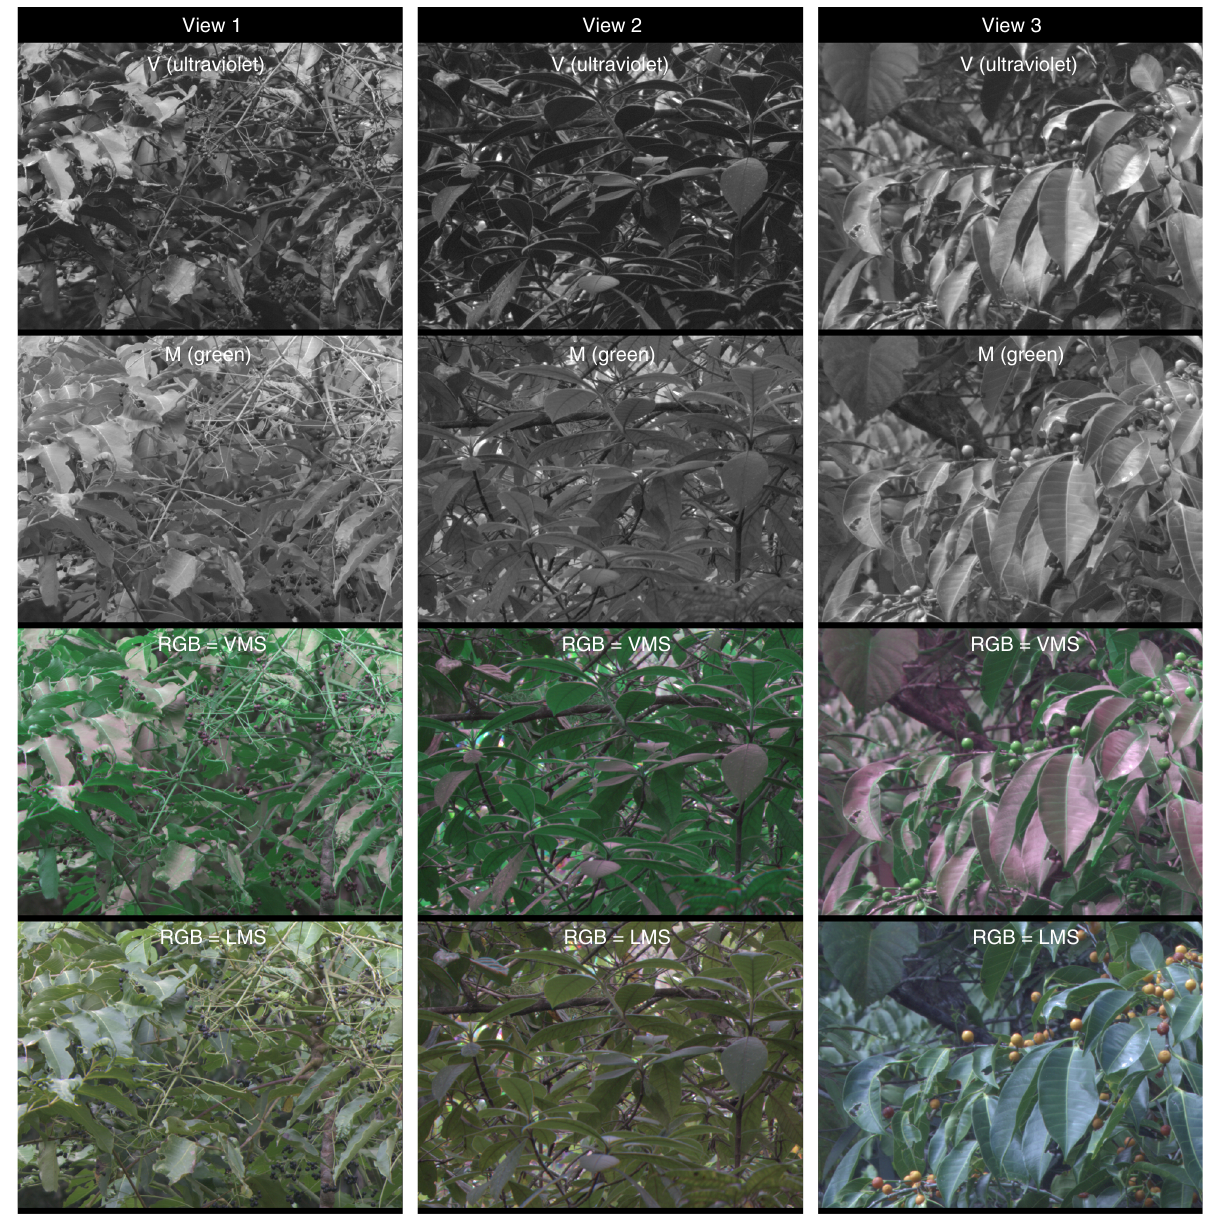
Fig. 4 Example images showing the difference in leaf-contrast seen by the UV- and green-cones in rainforest habitats in Queensland, Australia. See Fig. 2 legend for further